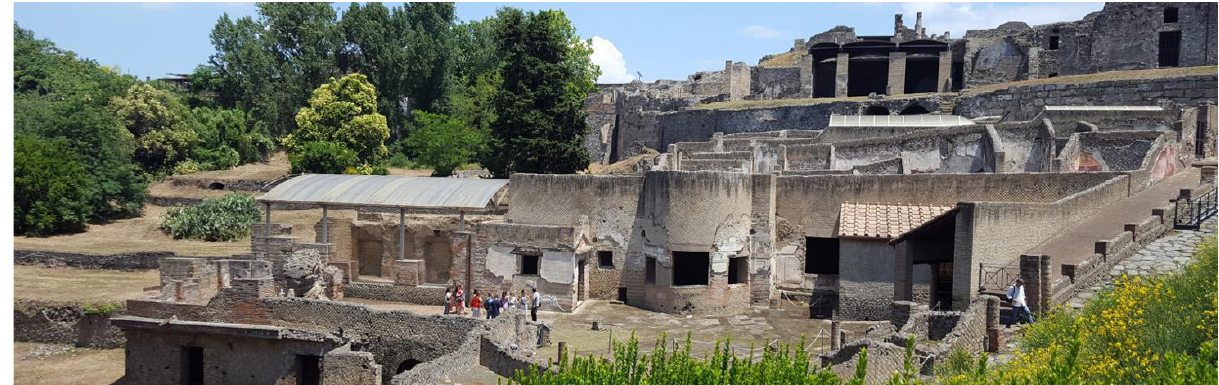
Figure 1. The Suburban Thermal Baths in Pompeii. Current use of the archeological site; it is necessary to improve its fruition. (ph: S. Borea,